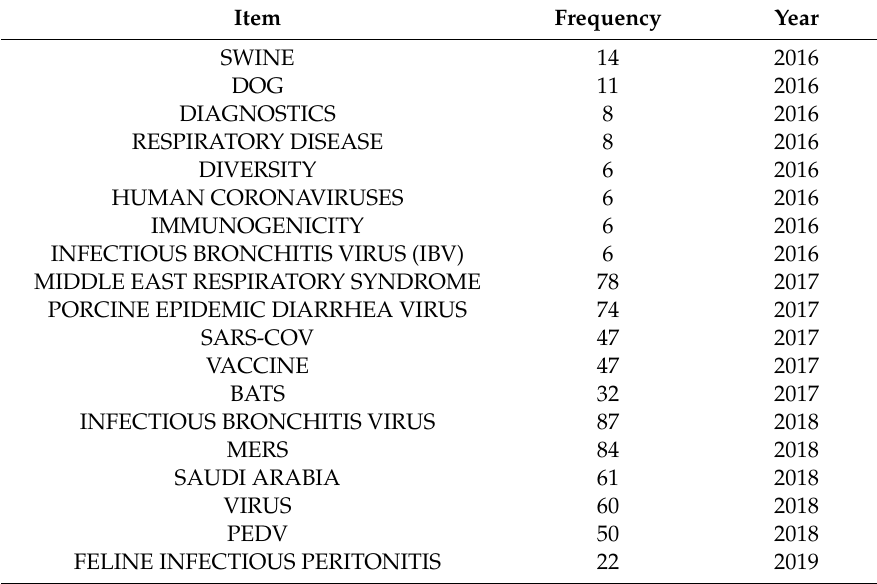
Table 10. Top cited papers with over 100 citations during 2016 – 2019. Author Name